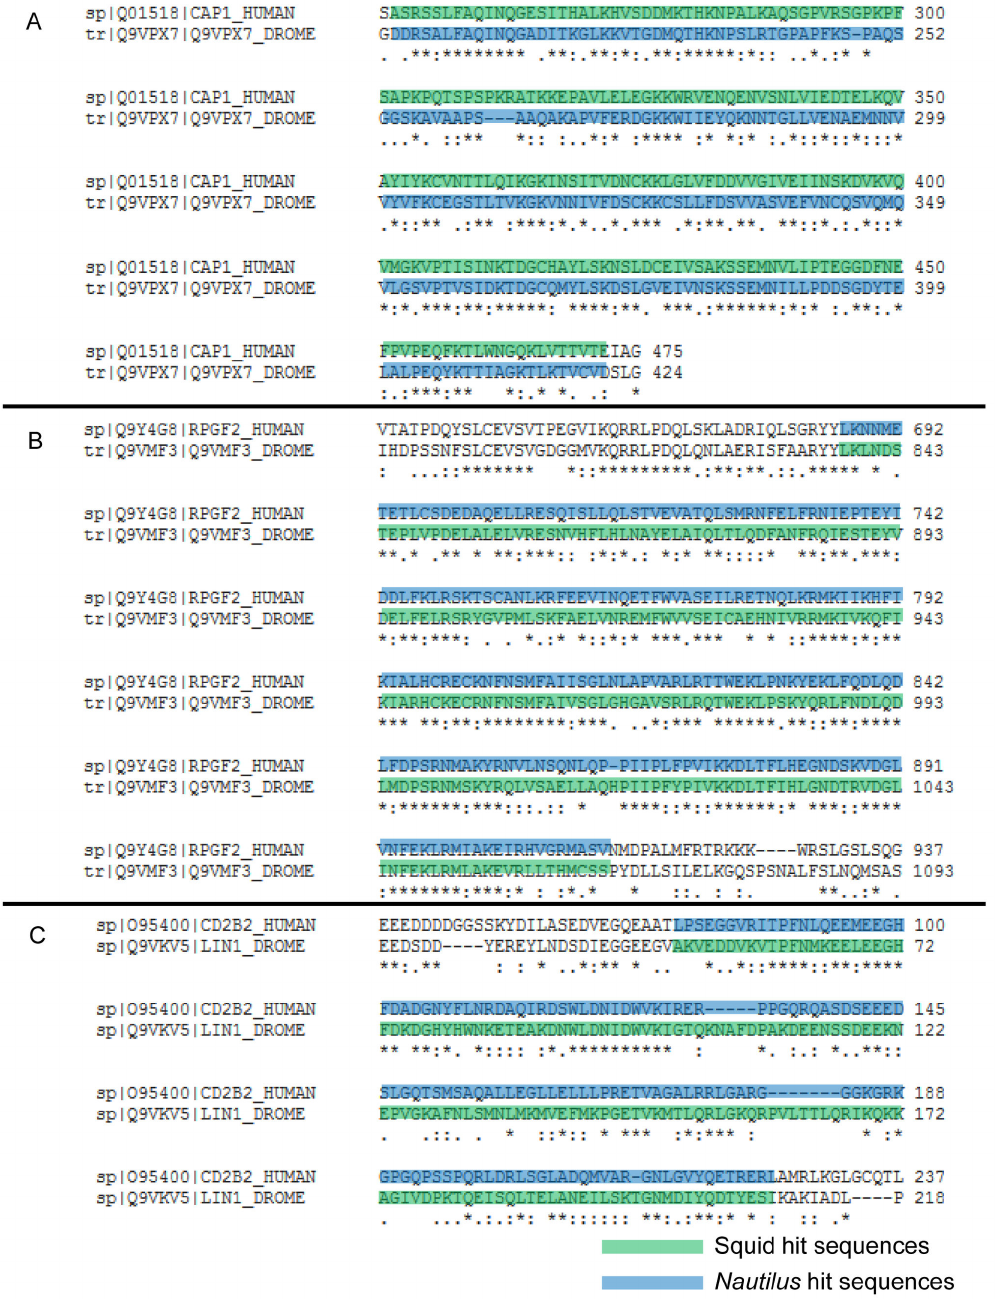
Figure 5. Alignments of the three gene pairs found to be selected for lens evolution in squids. Drosophila and Human homologue protein sequence were aligned using ClustalW2 to show conserved regions. Highlighted areas indicate the squid or Nautilus hit sequences with their counterpart homologues in Human or Drosophila. Proteins are labeled with their UniProt entry. A. CAP1/capt gene pair alignment. Squid has a best hit with the Human homologue (CAP1; CAP1_HUMAN) while Nautilus has a best hit with the Drosophila homologue (capt; Q9VPX7_DROME) in the same region. B. RAPGEF2/Gef26 gene pair alignment. Squid has a best hit with the Drosophila homologue (Gef26; Q9VMF3_DROME) while Nautilus has a best hit with the Human homologue (RAPGEF2; RPGF2_HUMAN) in the same region. C. CD2BP2/CG5198 gene pair alignment. Squid has a best hit with the Drosophila homologue (CG5198; LIN1_DROME) while Nautilus has a best hit with the Human homologue (CD2BP2; CD2B2_HUMAN) in the same region. Asterisk(*) indicate sequence identity, colon(:) indicates strongly similar properties and period(.) indicates weakly similar properties (ClustalW2). doi: 10.1371/journal.pone.0078054.g005 PLOS ONE |